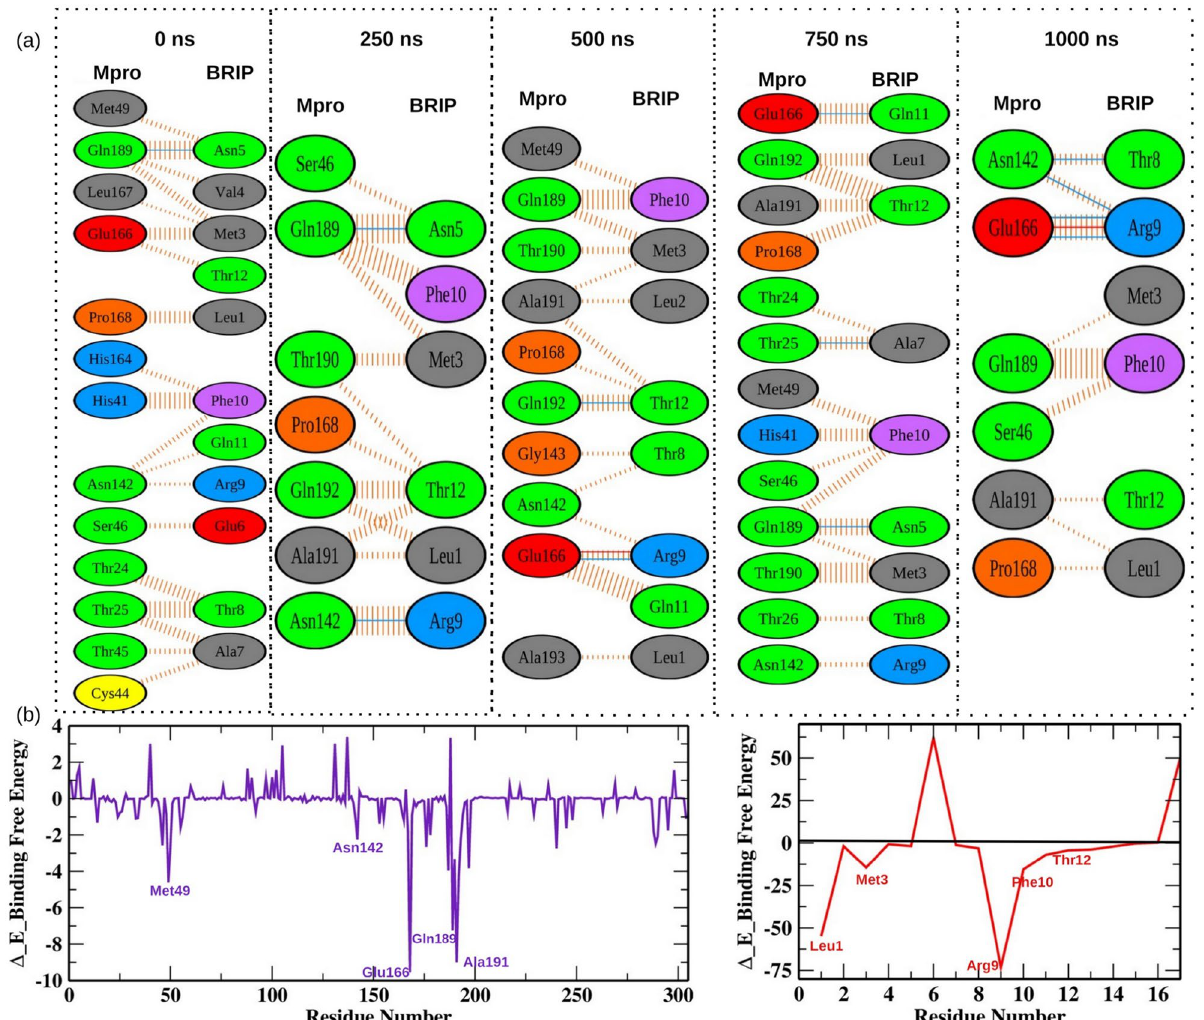
Figure 6. The key residues involved in M pro -BRIP interactions. ( a ) The interaction profiles of static poses extracted at different time intervals during the simulation. The solid blue and red color lines represents hydrogen bonds and salt bridges respectively, while the striped lines denote non bonded interactions. The residue color coding scheme is as follows: positive (blue), negative (red), neutral (green), aliphatic (gray), aromatic (purple), proline and glycine (orange). ( b ) The per residue contribution energy of M pro and BRIP observed for the entire simulation run by the MM-PBSA